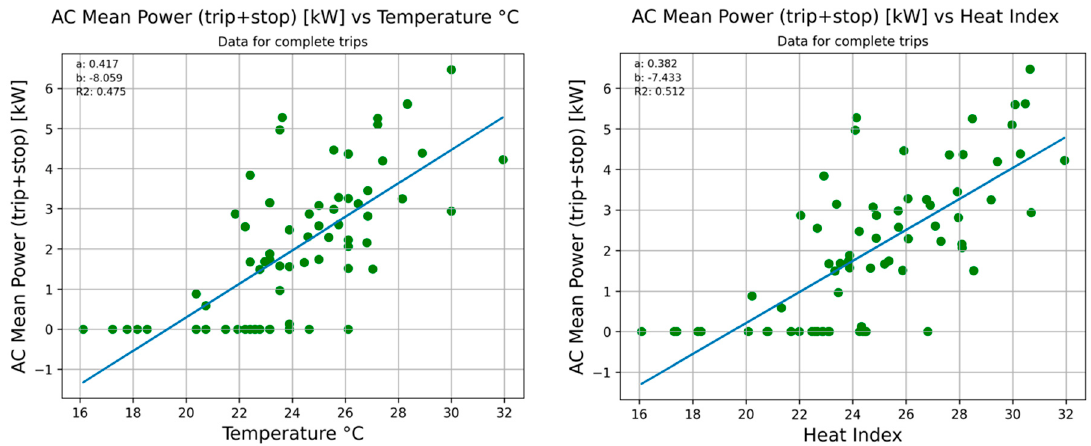
Figure 2. ( Left ) Average power in function of 2 m Temperature for each trip of the observational field campaign in Cagliari. The trip includes also the pause time at the bus stops. ( Right ) As the left panel in function of Heat Index instead of Temperature.